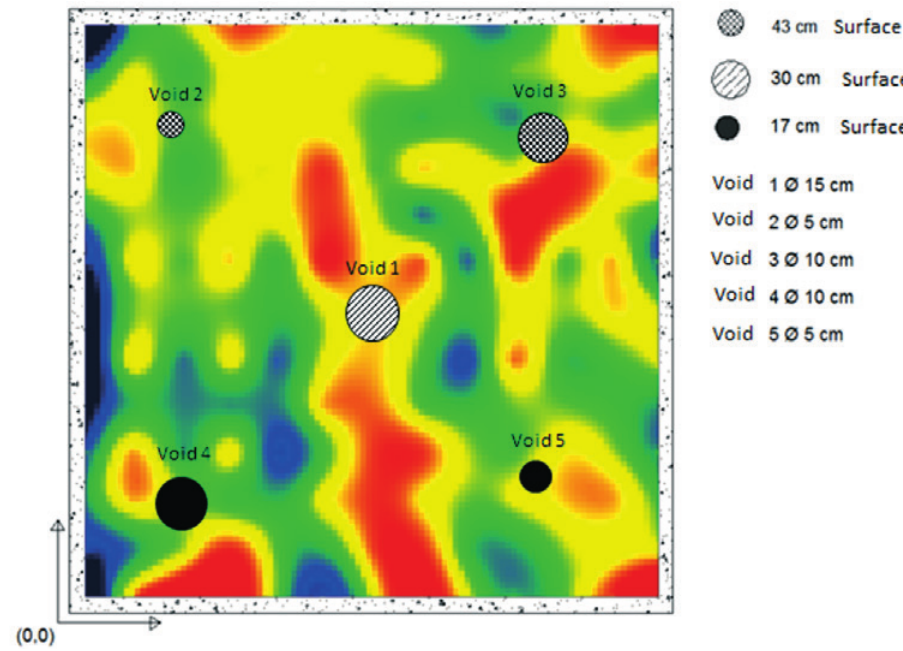
Image generated through a combination of parameters to identify